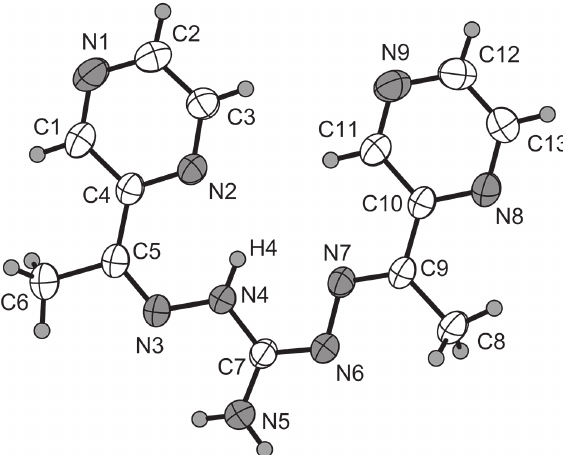
Table 2: Fractional atomic coordinates and isotropic or equivalent isotropic displacement parameters (Å 2